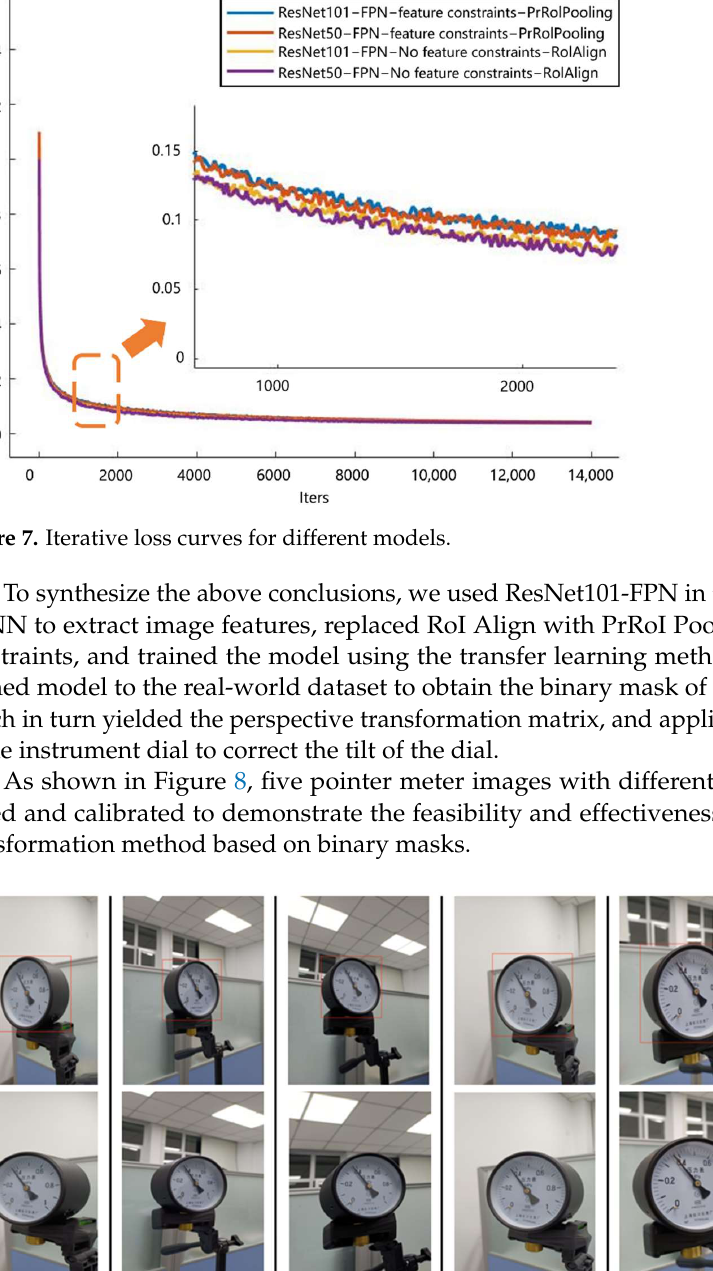
Table 5. Availability of different models.